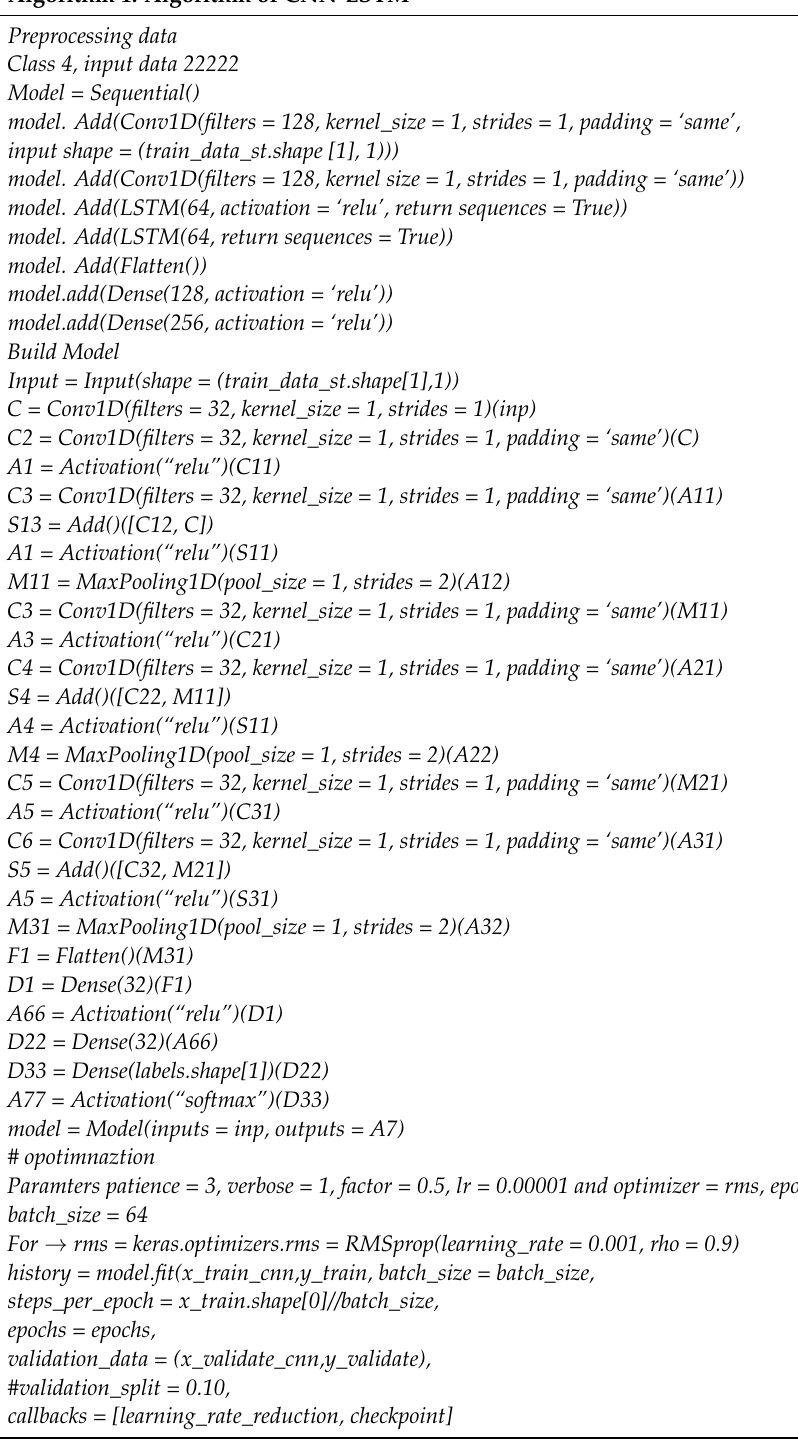
Algorithm 1. Algorithm of